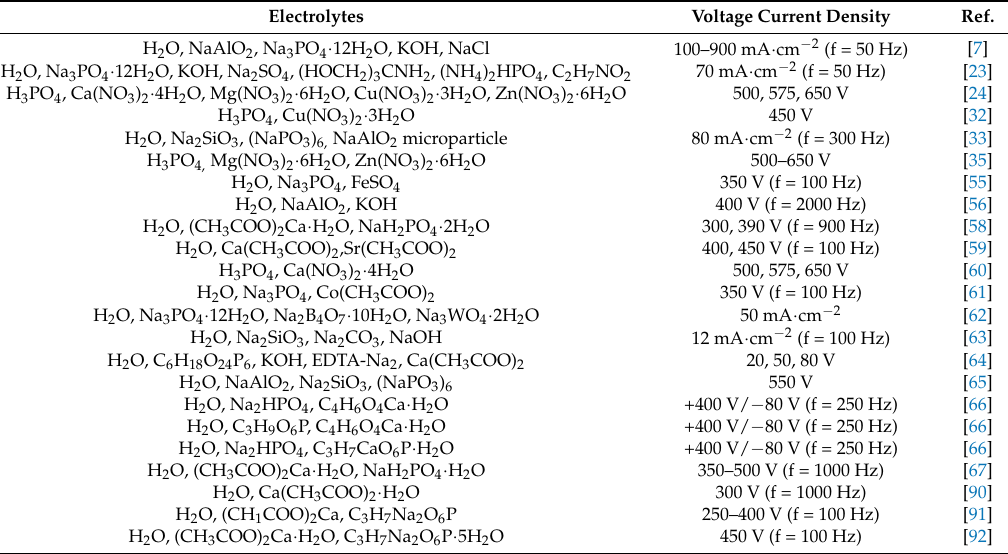
Table 1. Electrolytes and conditions of the plasma electrolytic oxidation (PEO) process. Electrolytes Voltage Current